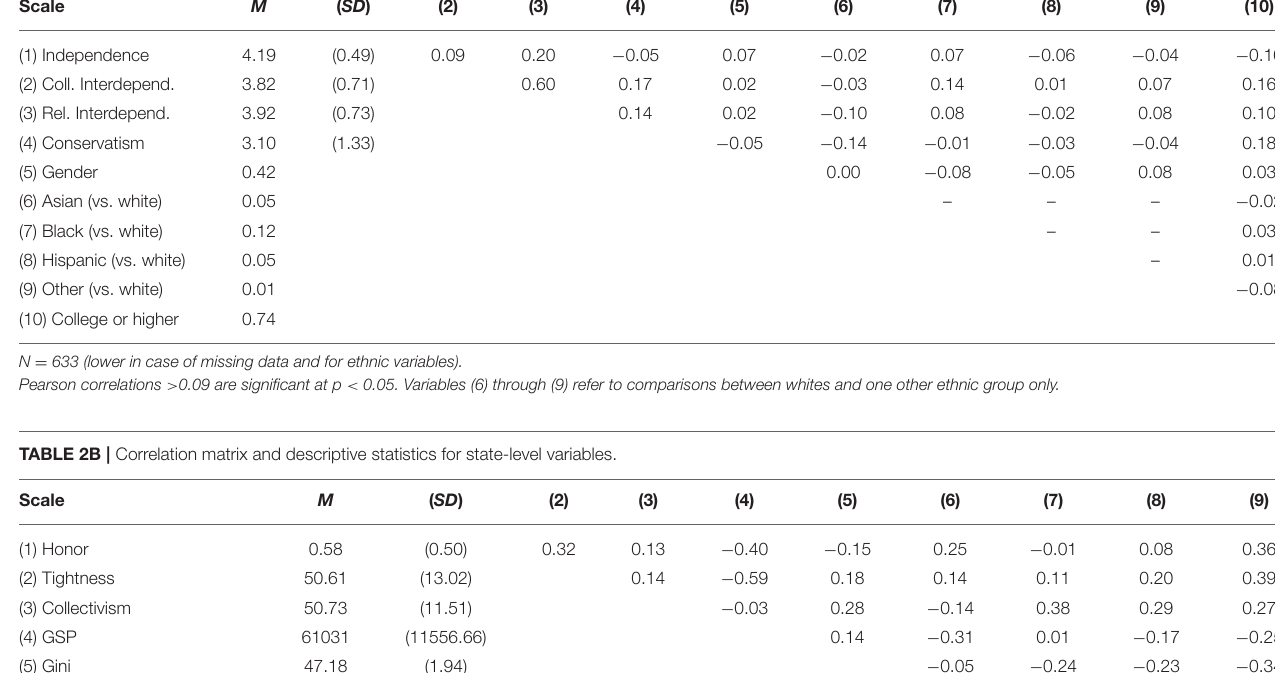
TABLE 2A | Correlation matrix and descriptive statistics for individual-level variables. Scale